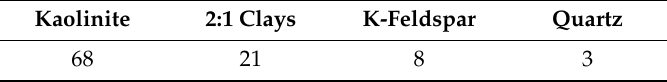
Table 2. Mineralogical composition (wt%) of kaolin measured by XRD.